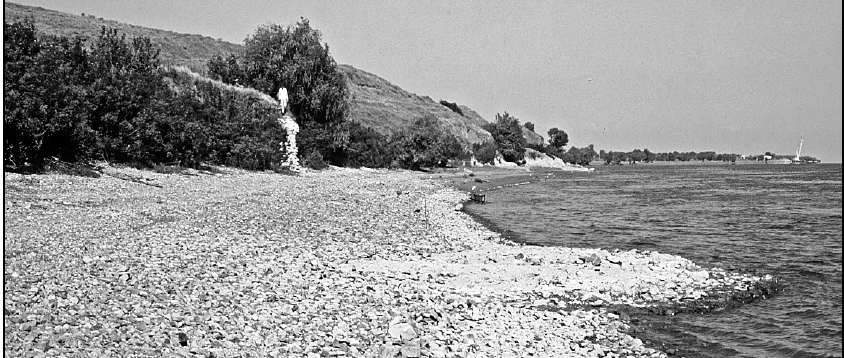
Figure 2 One of the bastions of the late-Roman fortress still visible in 2000 on the shore of the Danube at